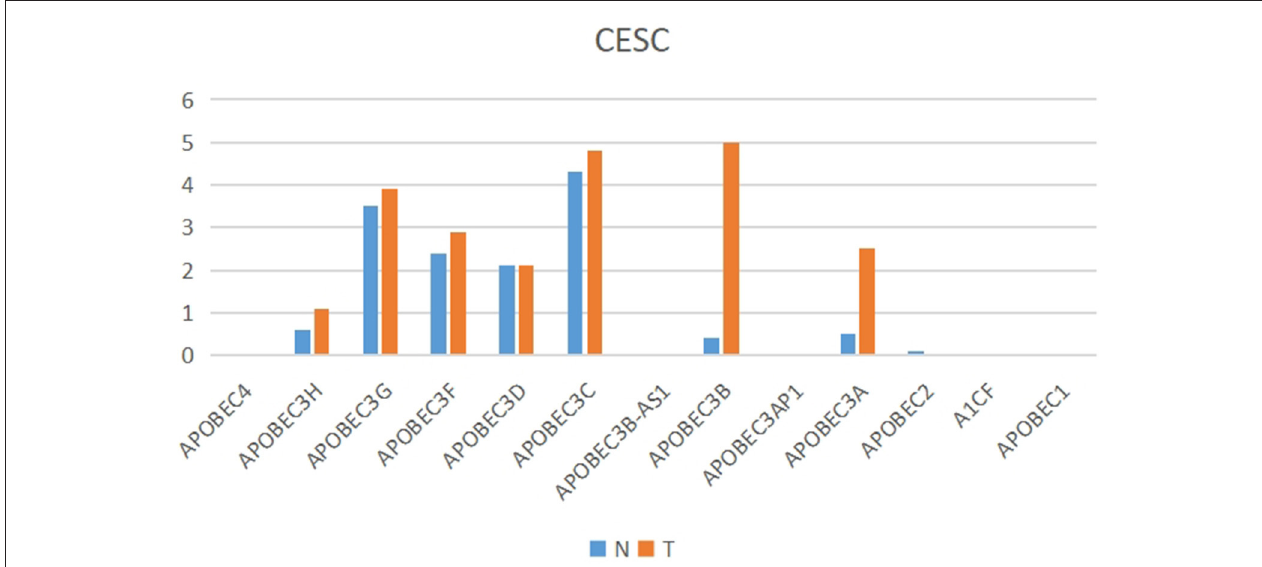
FIGURE 6 | Multiple gene expression analysis of the APOBEC family in CESC. Among the APOBEC gene family, the expression of APOBEC3A and APOBEC3B was significantly higher in tumor tissues than in normal tissues.